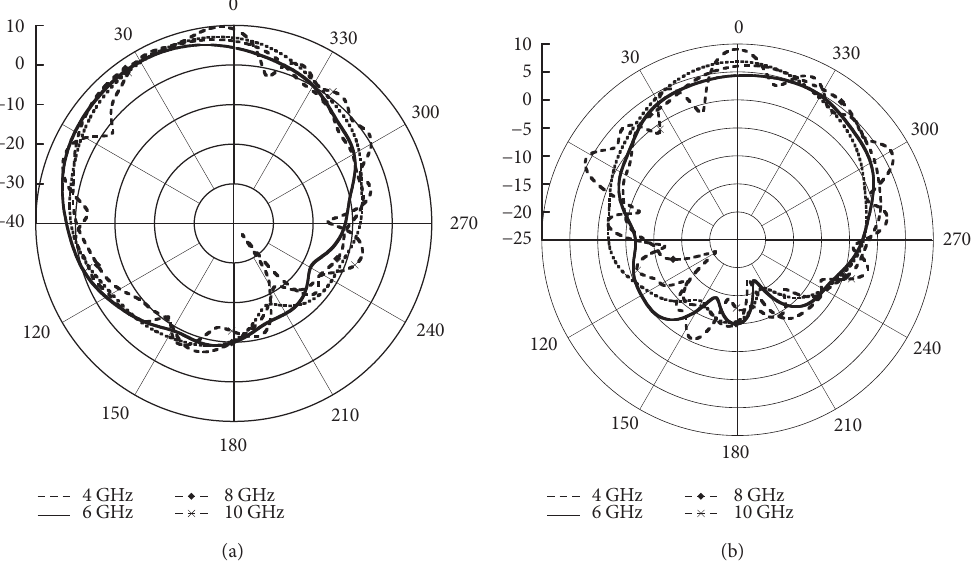
F 3: Antenna radiation pattern, on the